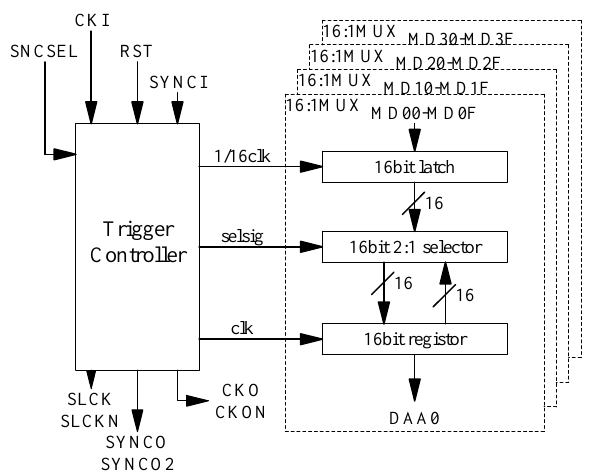
FIG. 3. Block diagram of the FDMUX LSI. CKI: clock in- put (PECL); RST: reset input (LvTTL); SYNCI: synchroniza- tion timing input (PECL); SNCSEL: synchronization timing selection (LvTTL); SLCK and SLCKN: synchronization tim-